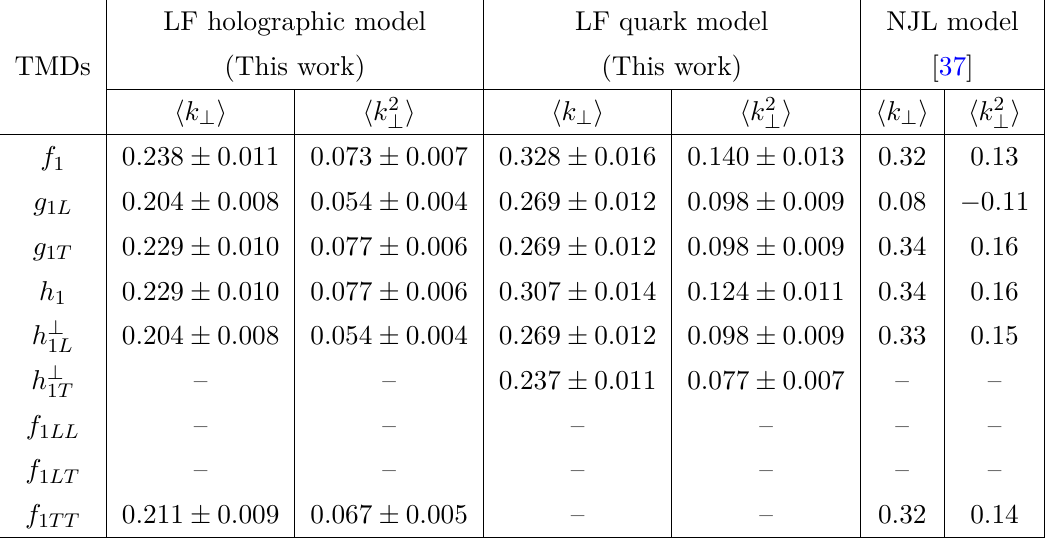
i [in GeV 2 ] predictions ⊥